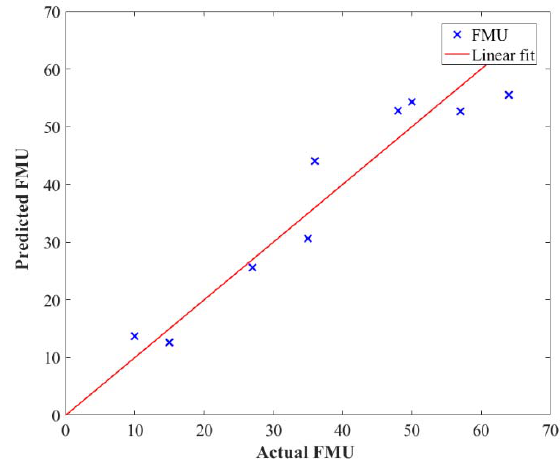
Figure 12. The linear fit of predicted versus actual FMU.